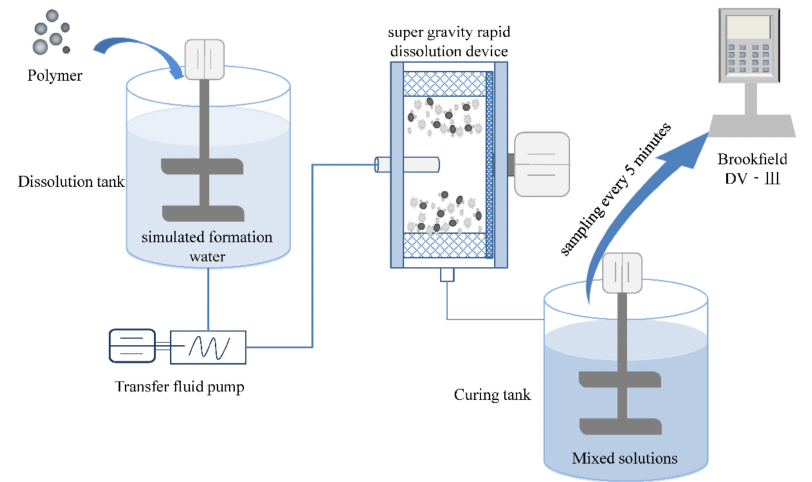
Figure 8. The process flow diagram of polymer preparation.